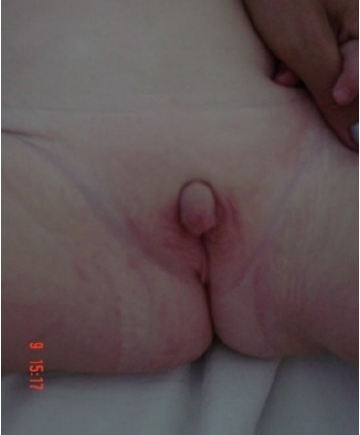
Figure 10. 46,XX DSD in a patient 6 months of age with 11 β -hydroxylase deficiency. Written informed consent was obtained from the parents for publication of this photo.